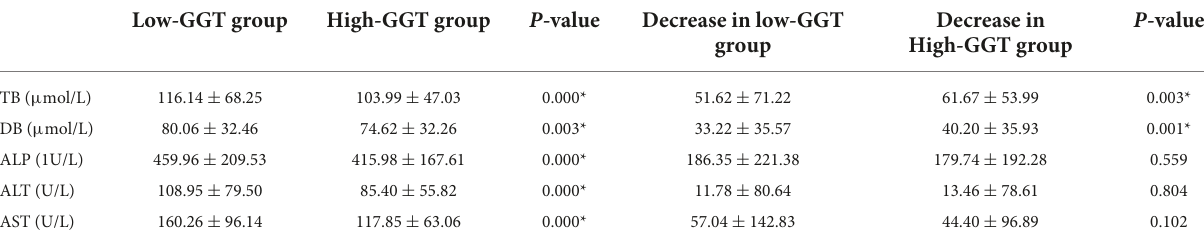
TABLE 2 The main indicators of liver function 2 weeks after operation and their decrease compared to preoperative levels in the low and high-GGT groups.